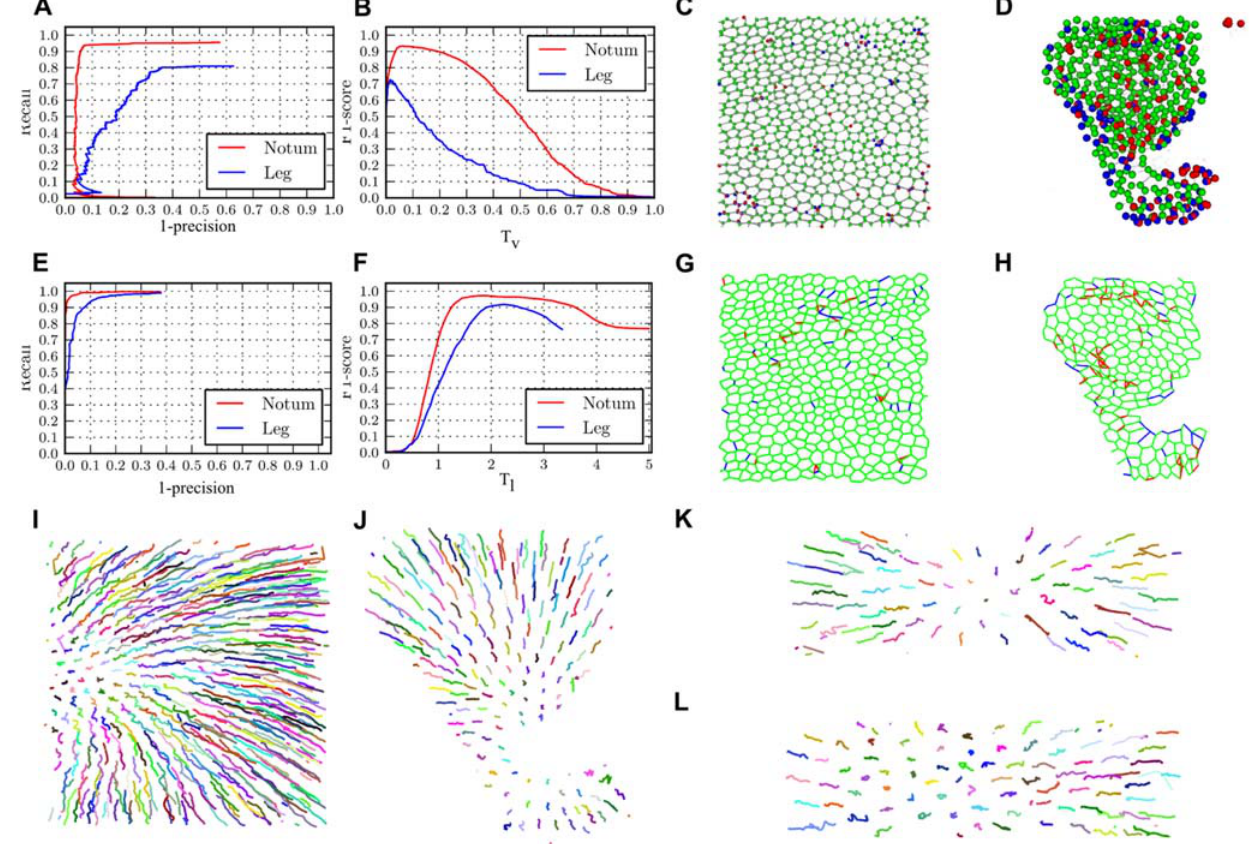
Fig 4. Performance assessment of the automated detection of vertices, cell-cell contacts and cell tracks. A-D) Evaluation of the vertex detector, E-H) edge detector, and I-J) cell tracker. C-D), G-H) Green — true detections, blue — missed detections, red — false detections. A) Precision-Recall curve for AJ vertex detection. B) Variation of the F 1 score of the vertex detector relative to changes in detection threshold T V . Vertex detection of C) Notum and D) Leg datasets. Vertex location accuracy highly depends on properly tuning up T v . E) Precision-Recall curve for AJ edge detection. F) Variation of the F 1 score relative to changes in propagation threshold T E . Edge detection in G) Notum and H) Leg datasets. Edge detection is more robust than vertex detection. I), J), K) and L) 2D projection of the trajectories respectively found for the cells in E) Notum, F) Leg, G) Mitosis in notum and H) Apoptosis in notum datasets. The system recovers accurate cell trajectories in different